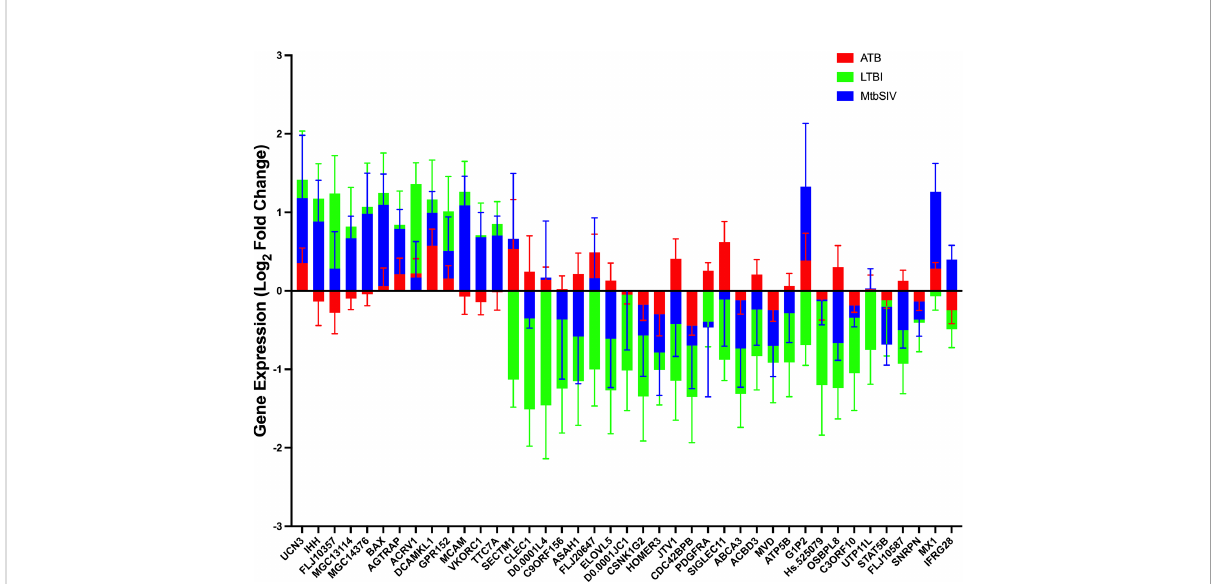
FIGURE 4 Stacked Mean Gene Expression. As an alternative visualization of the data, mean gene expression ± SEM of ATB (red), LTBI (green), and Mtb /SIV (blue) cohorts was